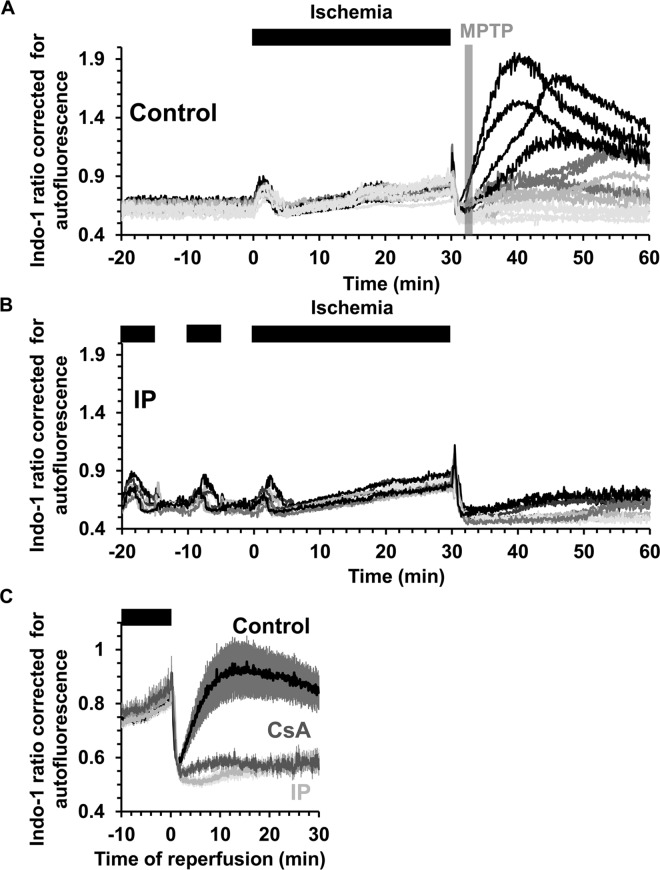
Measurement of [Ca2+] using Indo-1 in control and IP hearts during ischemia / reperfusion.Indo-1 fluorescence ratio corrected for autofluorescence was monitored in control (A) and IP (B) hearts undergoing 30 min global ischemia and reperfusion. C, Mean data (± SEM as error bars) for control (black, n = 15), IP (light grey, n = 10) and CsA-treated hearts (dark grey, n = 10) during the last 10 min of ischemia and 30 min of reperfusion. In CsA-treated hearts, 0.2 μmol/L CsA was present in the perfusion medium for 10 min before ischemia and for 30 min of reperfusion (n = 10). Corresponding infarct sizes are presented in Table 1.